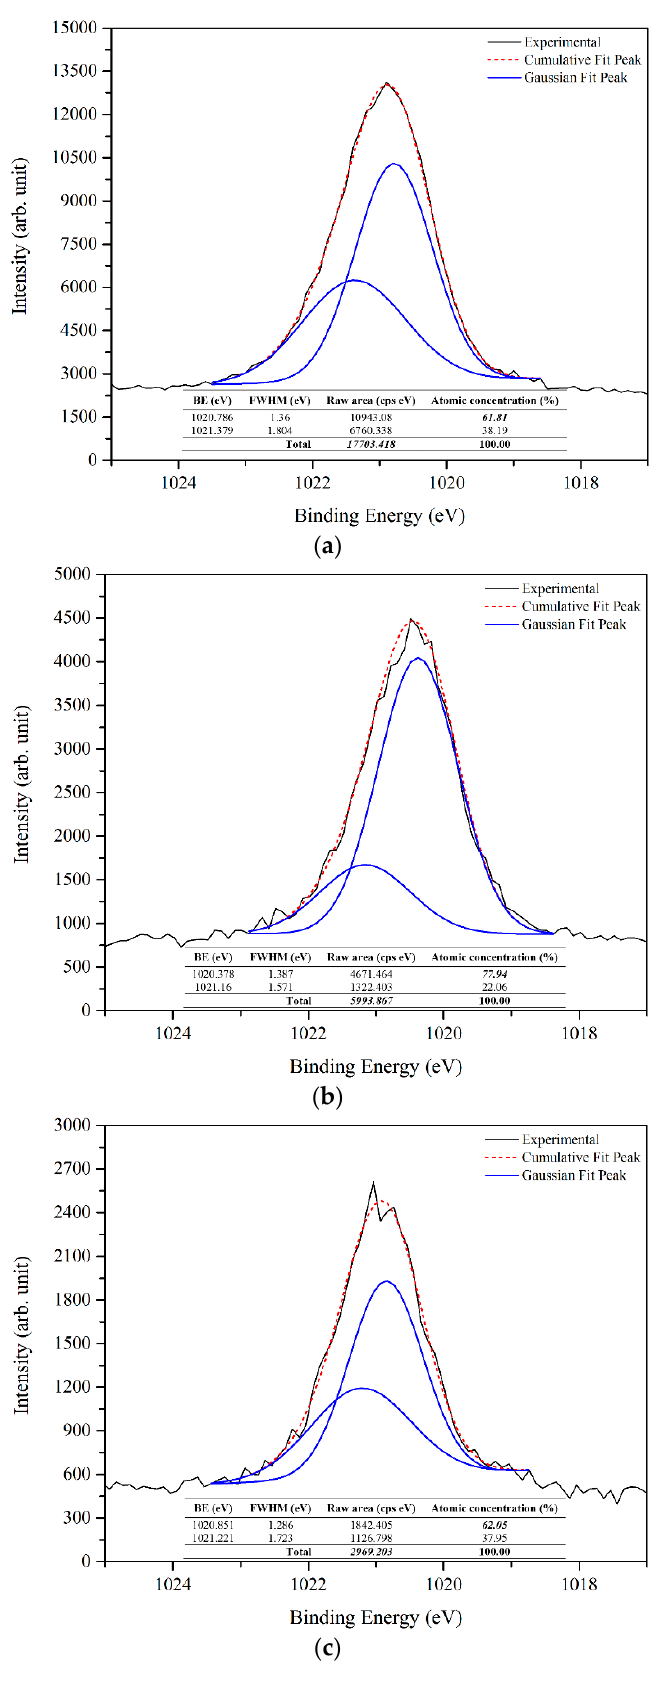
Figure 8. XPS analysis of zinc 2p 3/2 for as-deposited ZnO product grown at: ( a ) 500 C; ( b ) 600 C; and ( c ) 700 C.